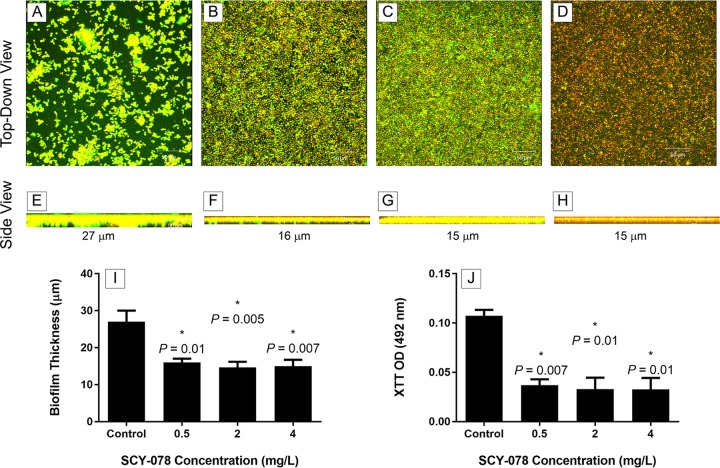
Confocal scanning laser microscopy analyses of the effect of SCY-078 on biofilms formed by C. auris. Biofilms formed by C. auris MRL 31102 were exposed to no drug (control) (A, E) or SCY-078 at different concentrations: 0.5 mg/liter (B, F), 2 mg/liter (C, G), or 4 mg/liter (D, H). Top-down views (A to D) and side views (E to H) of untreated and treated biofilms are shown. Magnifications, ×25. (I and J) The thickness (I) and metabolic activity (J) of untreated (control) and SCY-078-treated biofilms. *, P value compared to the results for the untreated control (no drug). A P value of <0.05 was considered significant. All experiments were done in triplicate, and the bars represent means ± SDs. SCY-078 exhibited potent activity against biofilms formed by C. auris strains.